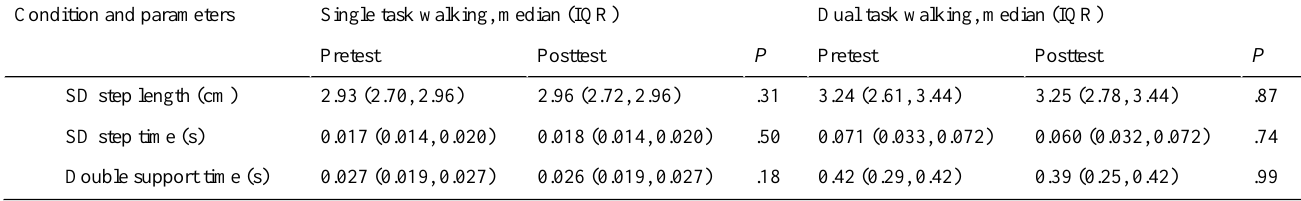
Table 4. P values of participants’walking performance (between-groups differences after intervention phase calculated with Mann-Whitney U test).